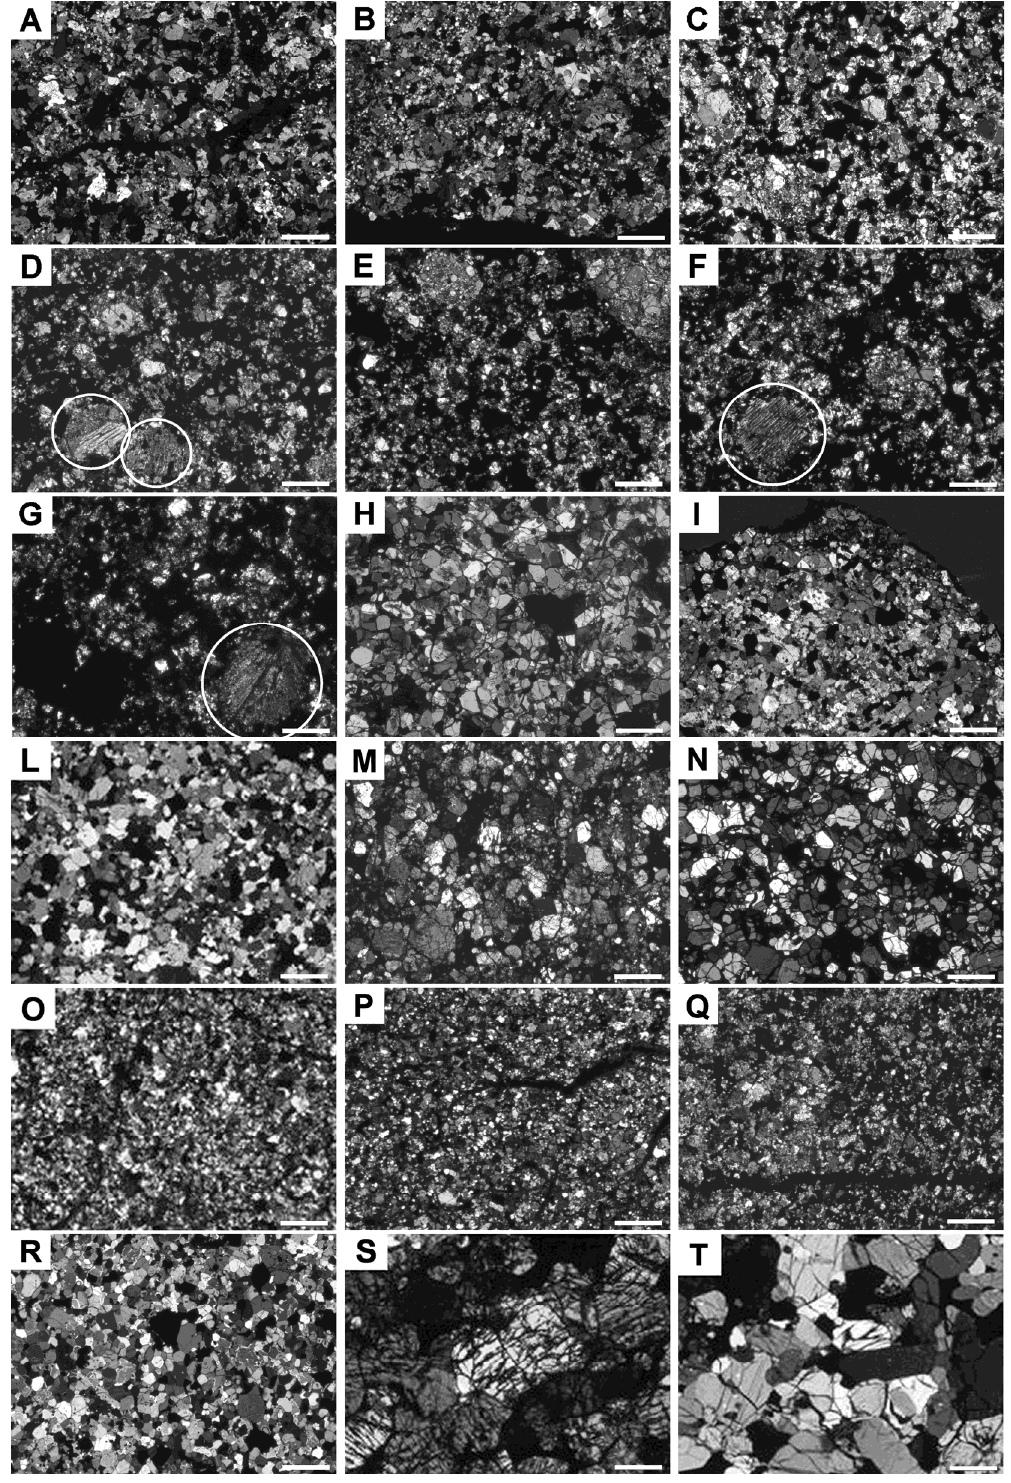
Figure 2. Photomicrographs of the thin sections of the meteorites investigated in the present study: ( A ) A-881902; ( B ) Y-74063; ( C ) GRA 98028; ( D ) NWA 1052; ( E ) NWA 1054; ( F ) NWA 1058; ( G ) NWA 1463; ( H ) NWA 3008; ( I ) Y-74025; ( L ) ALHA77081; ( M ) ALH 81187; ( N ) DHO 290; ( O ) QUE 94535; ( P ) Y-8005; ( Q ) Pontlyfni; ( R ) ALH 81261; ( S ) Y-74357; ( T ) Y-791491; transmitted light, crossed polars; scale bar is 500 μ m. Chondrules are highlighted with white